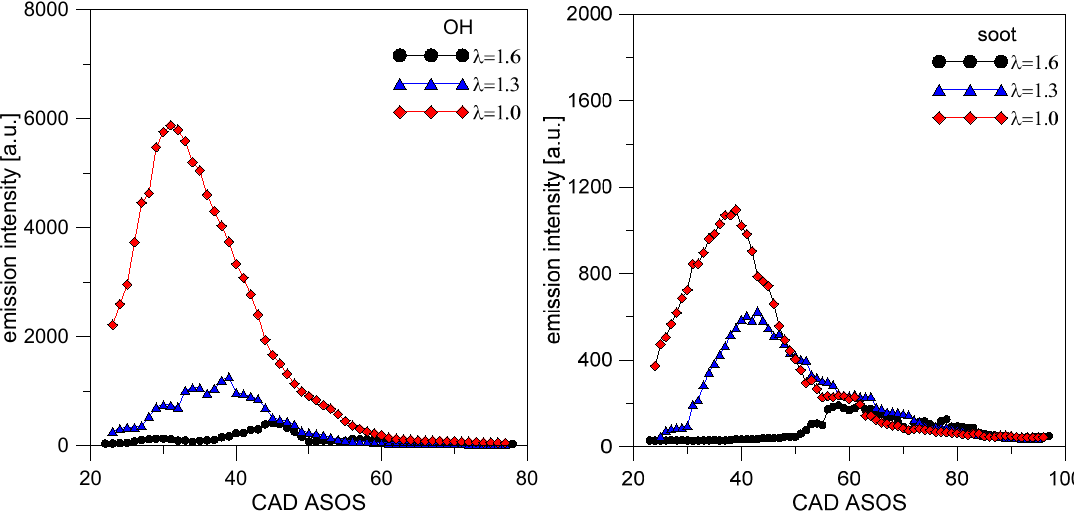
Figure 21. Evolution of emission intensity for OH ( left ) and soot ( right ) determined based on spectroscopic investigations.